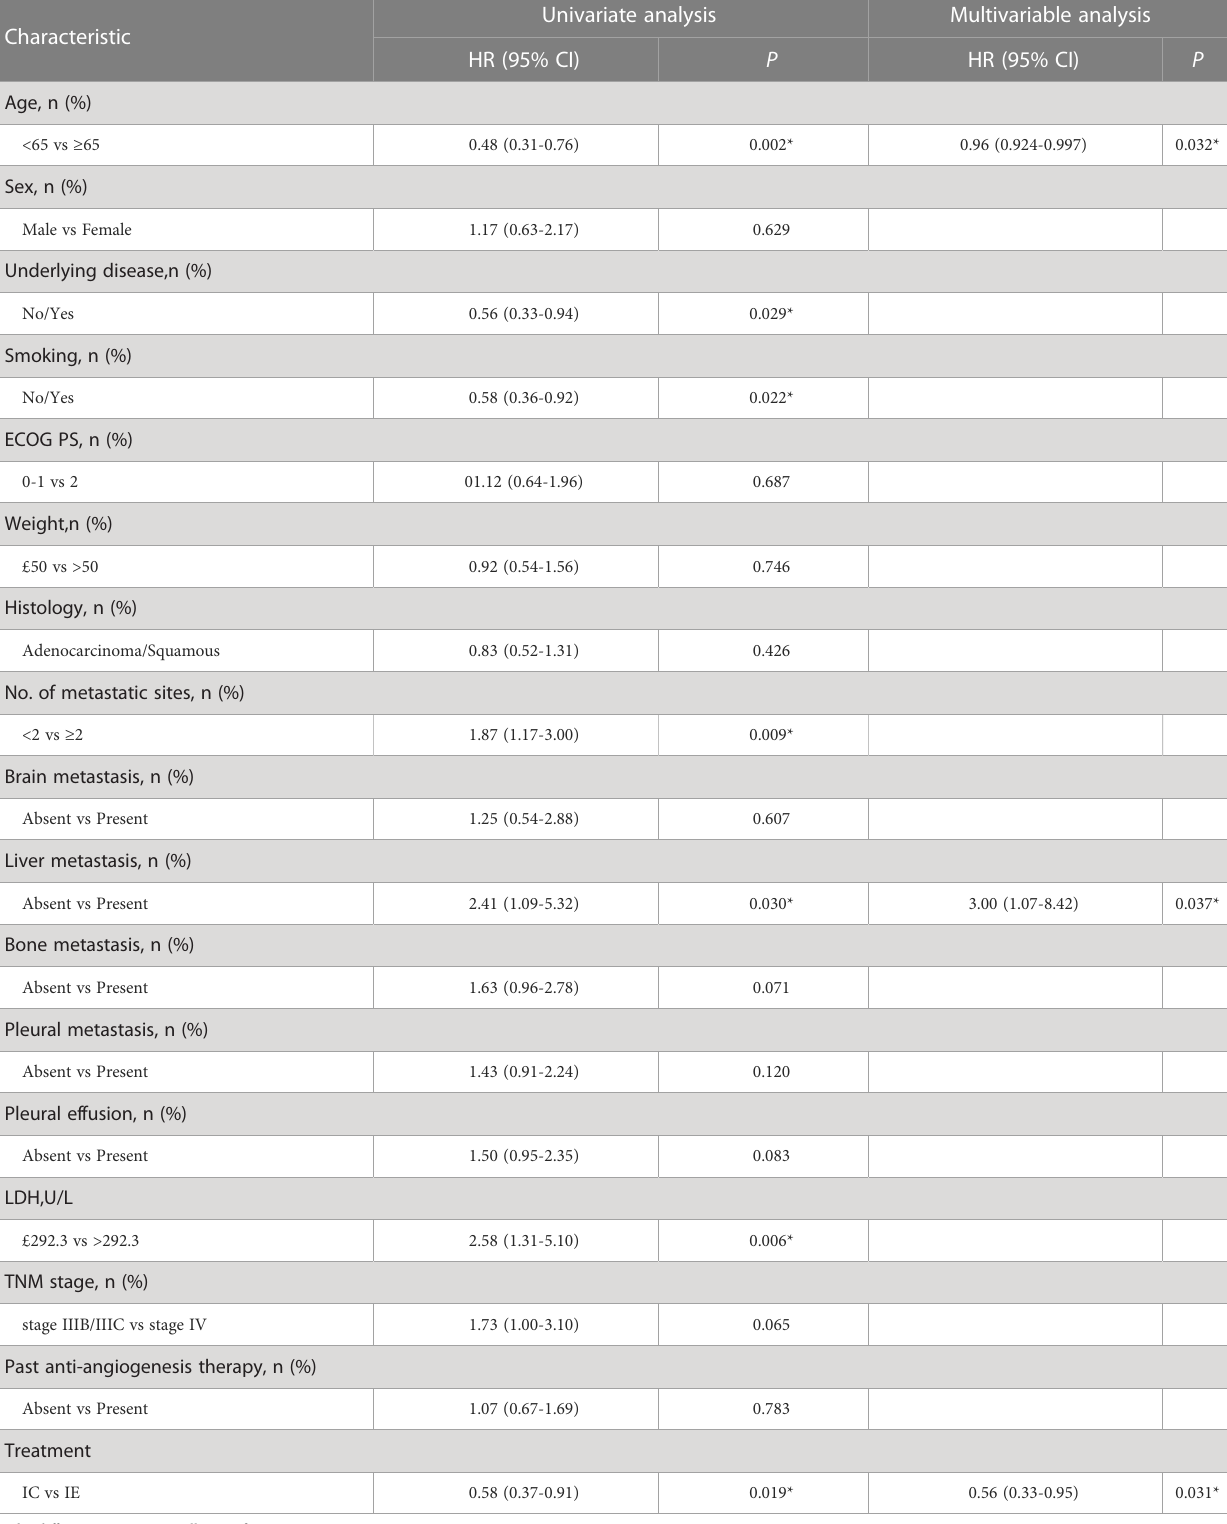
Univariate analysis Multivariable